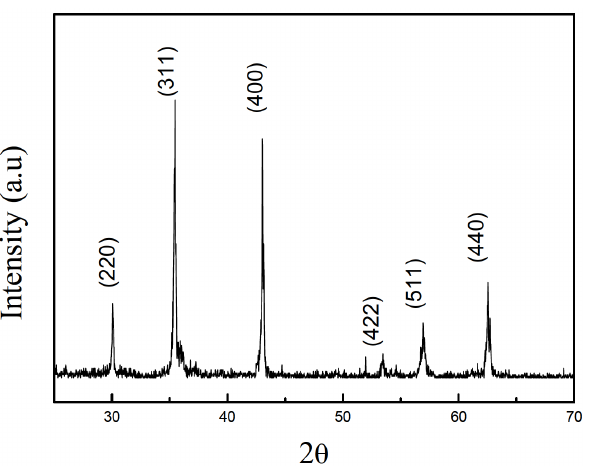
Figure 1: XRD patterns of Fe 3 O 4 particles.